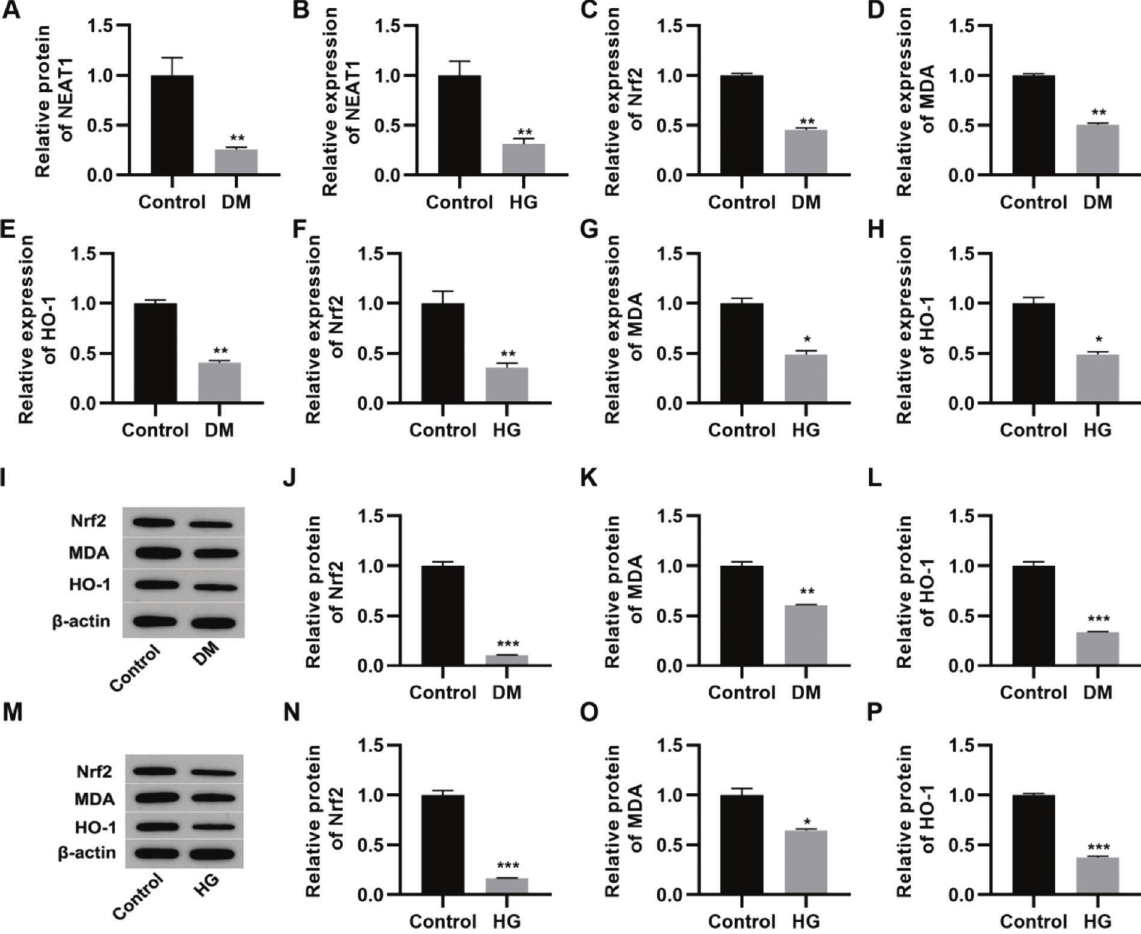
Figure 1 - NEAT1 is downregulated in patients with diabetes mellitus and H9c2 cells maintained in high-glucose medium. A, Expression of NEAT1 in patients with diabetes mellitus (DM); B, Expression of NEAT1 in H9c2 cells maintained in high-glucose (HG) medium; C-E, mRNA expression levels of Nrf2 , MDA , and HO-1 in patients with DM; F-H, mRNA expression levels of Nrf2 , MDA , and HO-1 in H9c2 cells maintained in HG medium; I-L, Western blotting of Nrf2, MDA, and HO-1 in patients with DM; M-P, Western blotting of Nrf2, MDA, and HO-1 in H9c2 cells maintained in HG medium. * p o 0.05, ** p o 0.01, *** p o 0.001, Mann-Whitney U